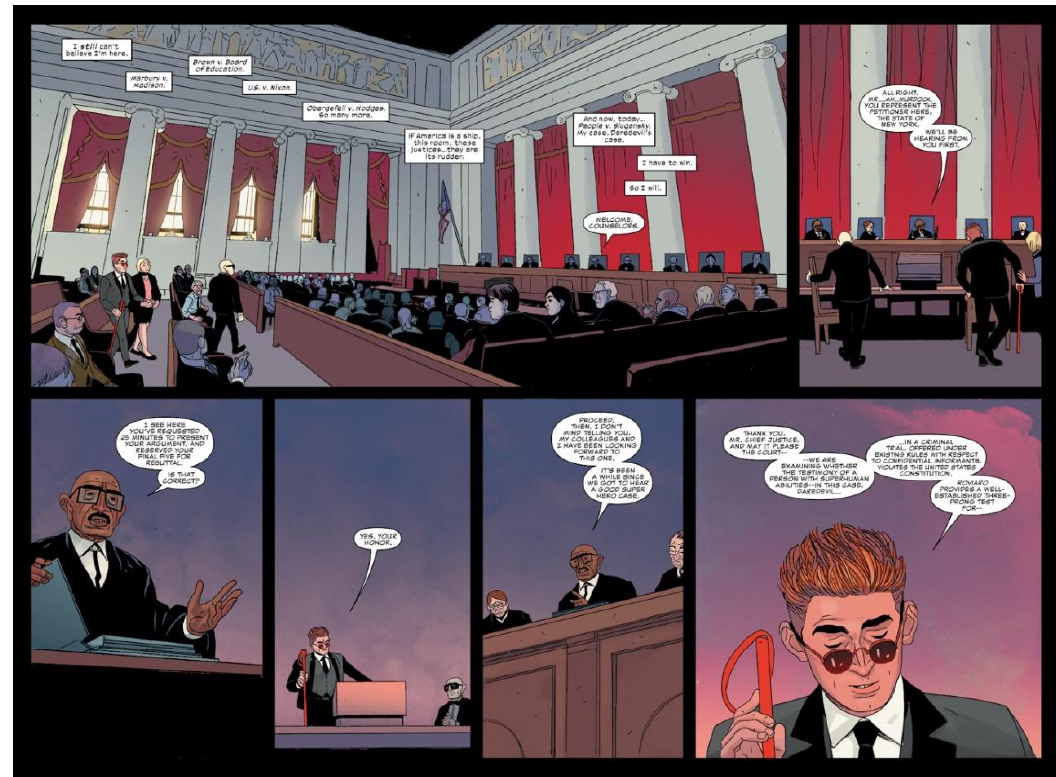
Figure 12. Panel from Soule’s Daredevil: Back in Black Vol. 5: Supreme #25, 2017.